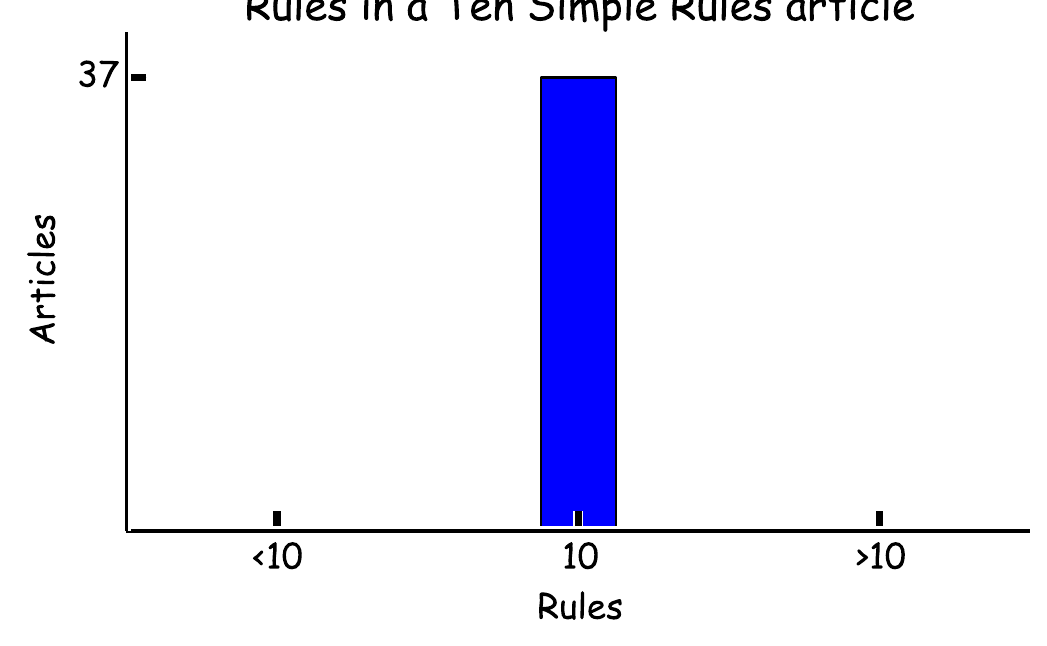
Figure 1. Have ten rules.